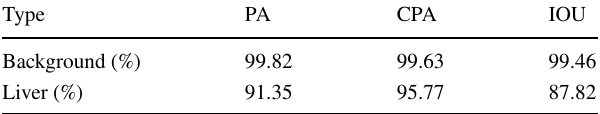
Table 4 Experimental results for the proposed methodology Model